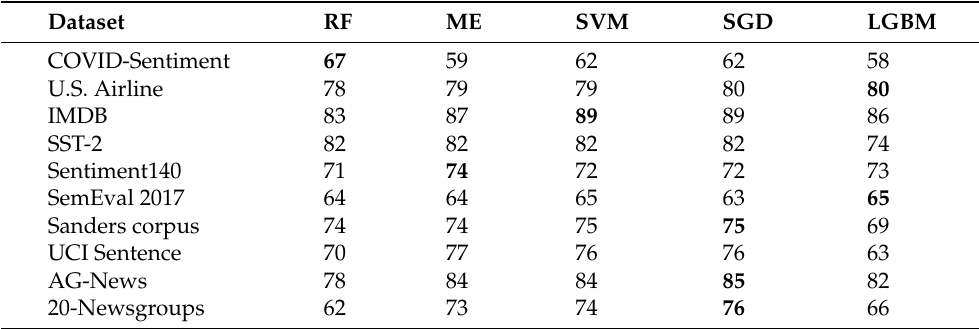
Table 5. TF-IDF-based weighted F1-score (rounded) results for five classifiers. Best results are in bold face.